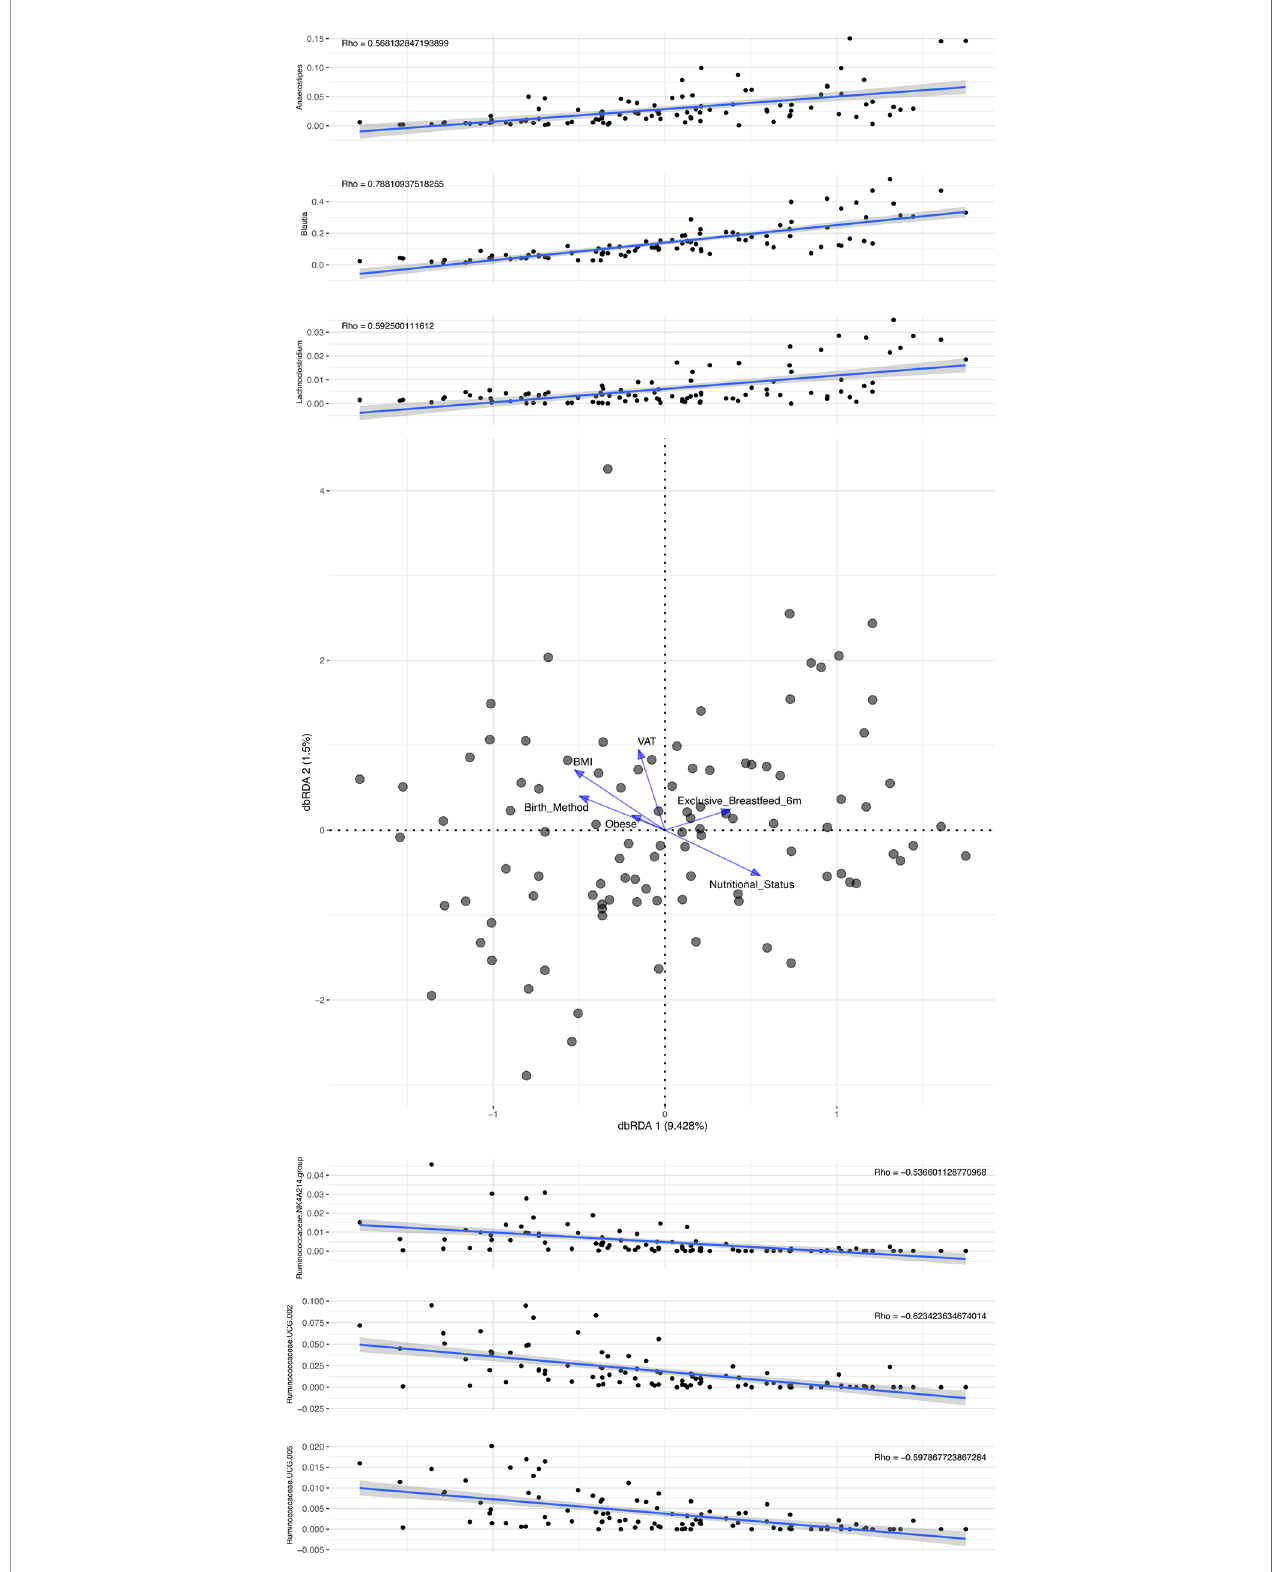
FIGURE 1 | Distance-based redundancy analysis identi fi ed in 114